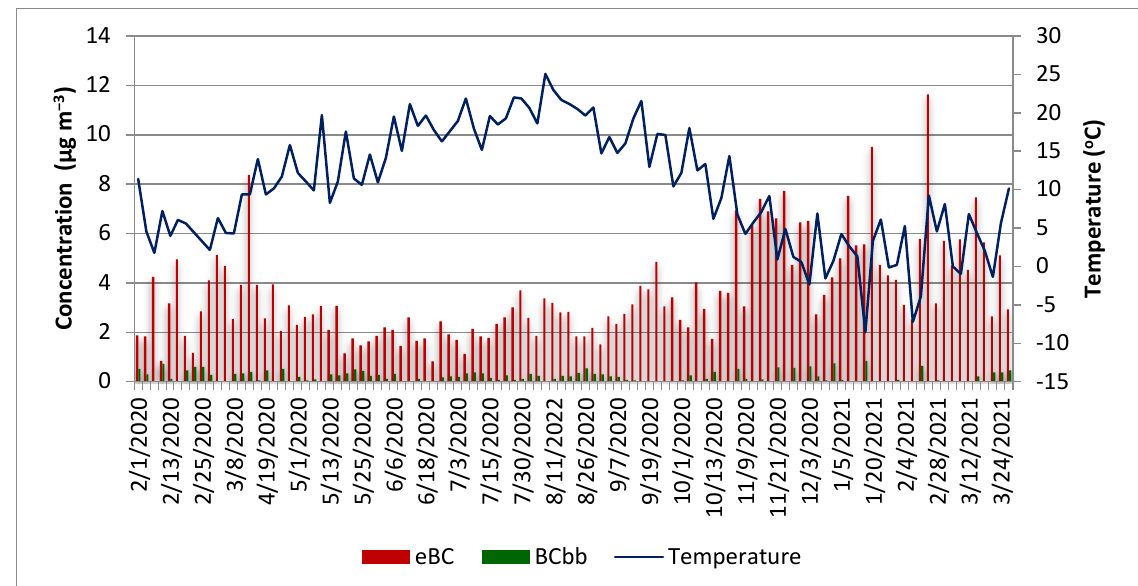
Figure 4. Comparison of daily concentrations between eBC and BC bb in µ g m − 3 and temperature in ◦ C for sampling from Krakow during February 2020–March 2021. The values of temperature were taken from the webpage: http://meteo.fis.agh.edu.pl/ (accessed on 8 December